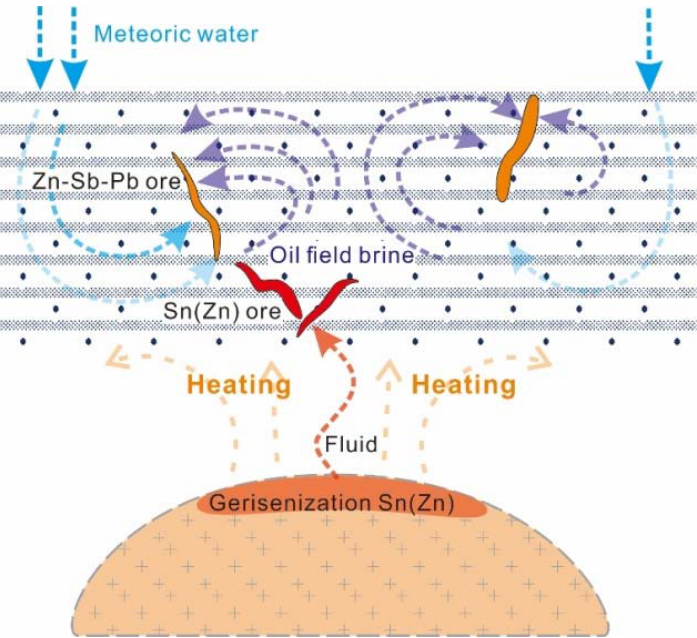
Figure 10. Schematic model of the Beixiang Sn polymetallic mineralization.